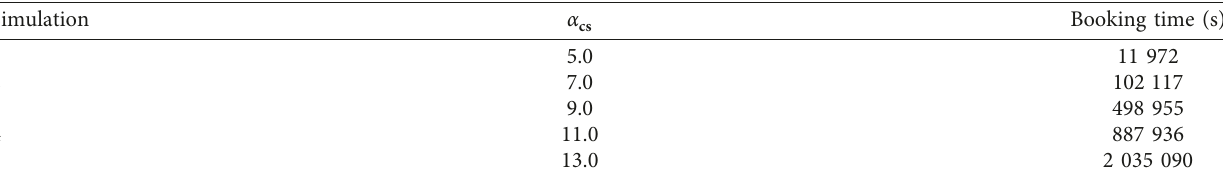
Table 2: CsC calibration phase one.